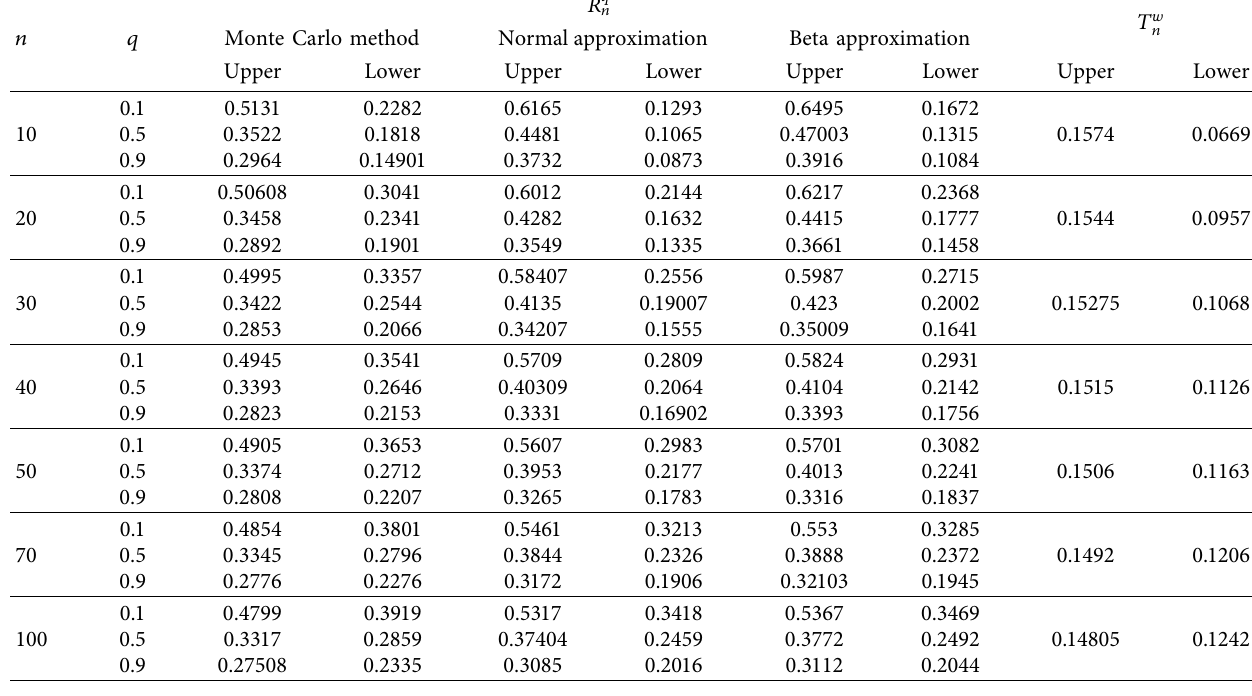
w � 0 . 05. n and T n at level α